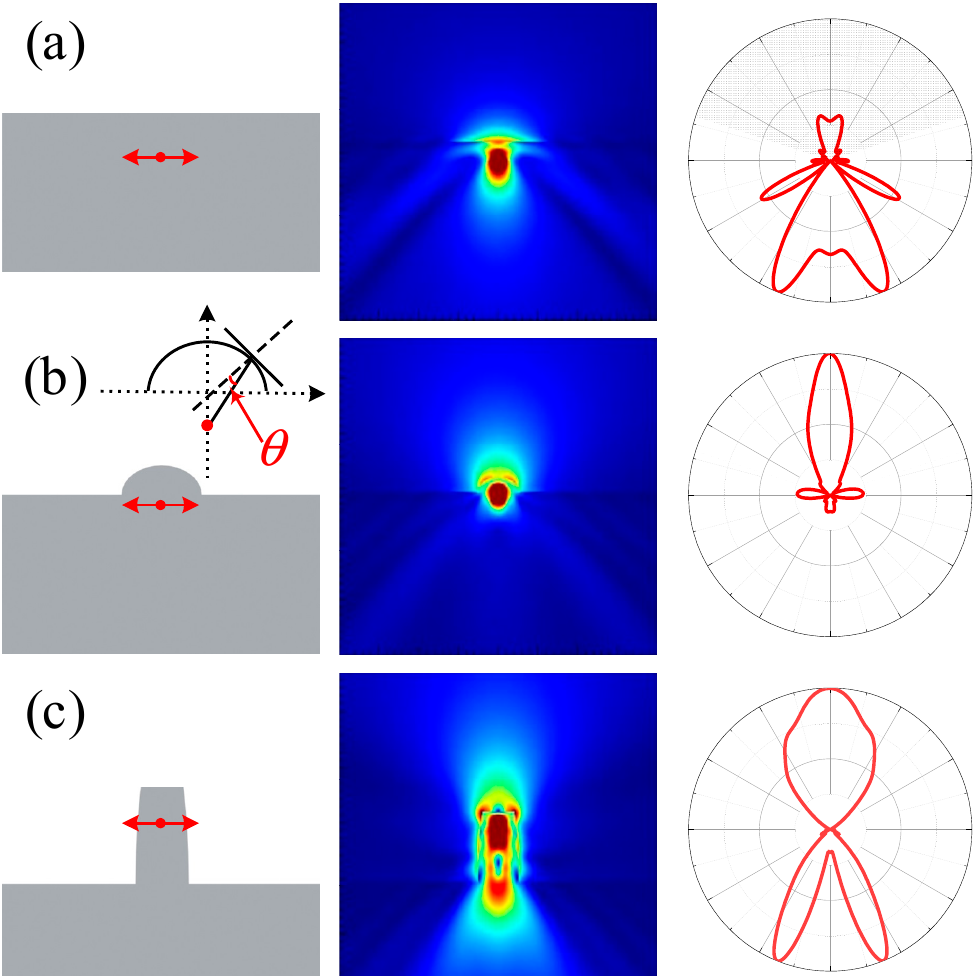
Figure 3. Simulation of electric field and far field of NV − center embedded in submicron structures. ( a ) NV − center in bulk diamond; ( b ) NV − center in micron lens with 500 nm diameter; inset, diagram of light propagation in lens. ( c ) NV − center in submicron cylinder. The first column demonstrates the positions of NV − center; the second column presents the corresponding electric field simulations; the third column presents the corresponding far-fields of NV − center in which the light grey shadows are the regions that can be detected by microscopy with NA of 0.95.